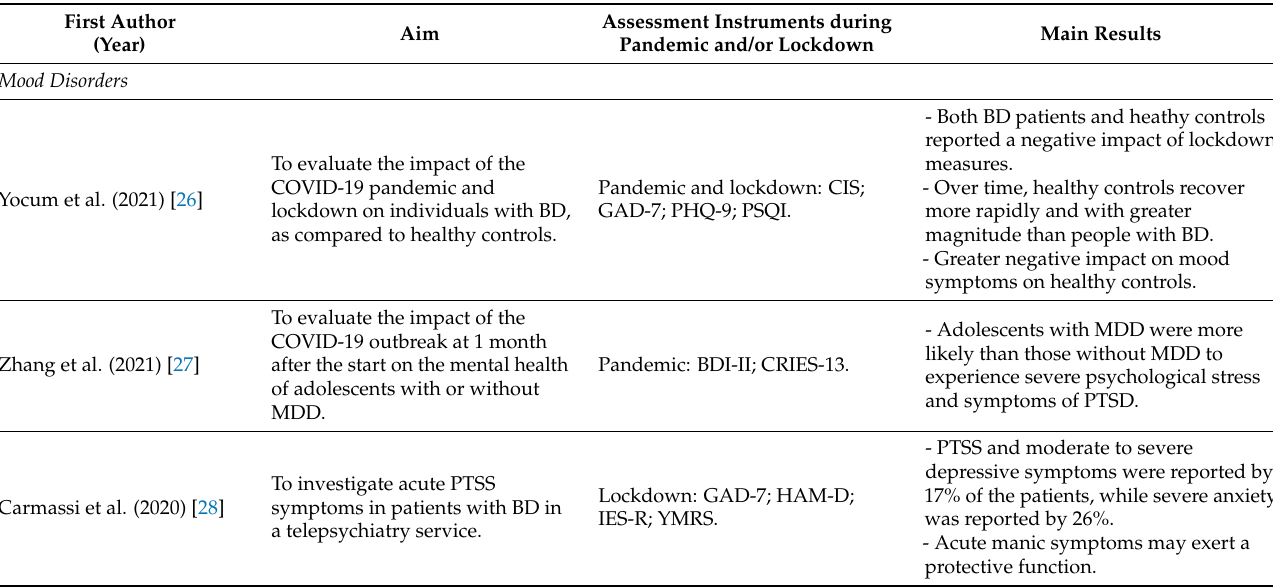
Table 3. Studies’ aims and main